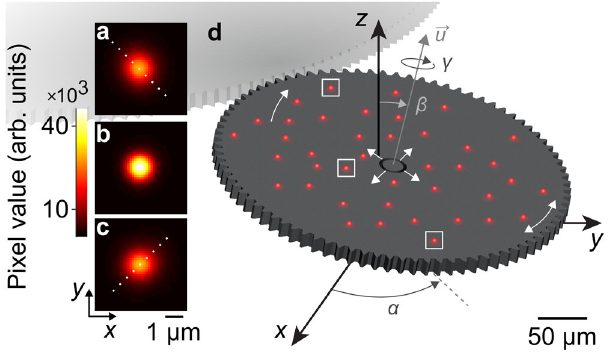
Fig. 1 Intrinsic aberrations enable accurate localization microscopy in six degrees of freedom. a – c Fluorescence micrographs showing images of a particle at z positions of ( a ) 2 µ m above, ( b ) near, and ( c ) 2 µ m below best focus. The particle diameter is 1 μ m and the resolution limit is 0.7 µ m. Two aberration effects are apparent – symmetry variation from astigmatism and intensity variation from defocus. Dots indicate asymmetry in ( a , c ). Vertical positions correspond to white boxes in ( d ). d Schematic showing (red) fl uorescent particles on part of a complex microsystem. We localize single particles in three dimensions and fi t a rigid transformation to measure motion with six degrees of freedom – translations Δ x , Δ y , and Δ z , intrinsic ! rotation γ about the axis of rotation u , nutation β , and precession α . White arrows indicate play due to clearances in the microsystem. ( d ) Lateral dimensions are nearly to scale. Vertical dimensions are not to